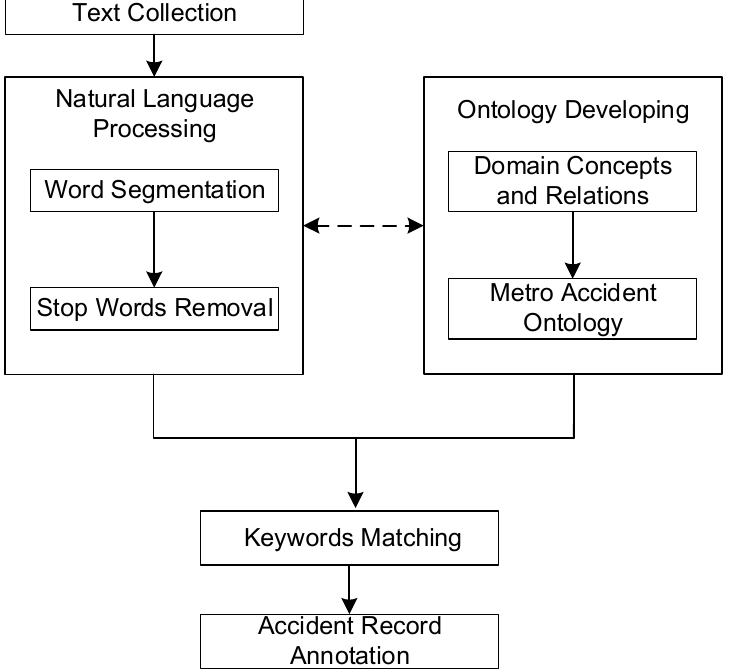
Figure 4. The annotation process of accident records.